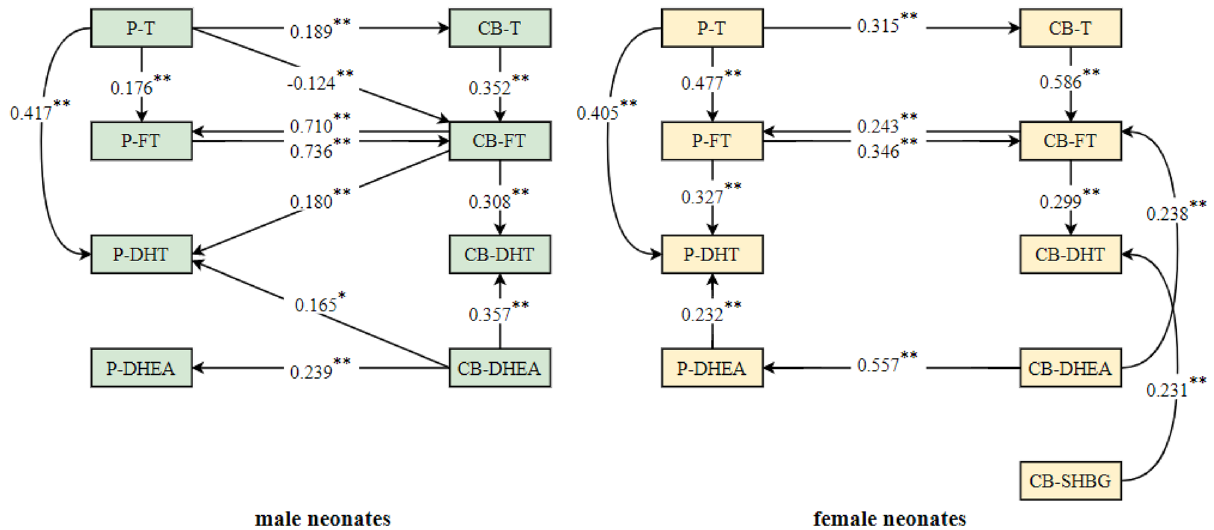
Figure 4. Preliminary association path models between prenatal androgens and cord blood androgens. Notes: P-T prenatal testosterone, P-FT prenatal free testosterone, P-DHT prenatal dihydrotestosterone, P-DHEA prenatal dehydroepiandrosterone, CB-T cord blood testosterone, CB-FT cord blood free testosterone, CB-DHT cord blood dihydrotestosterone, CB-DHEA cord blood dehydroepiandrosterone, CB-SHBG cord blood sex hormone binding globulin; * P < 0.05; ** P <